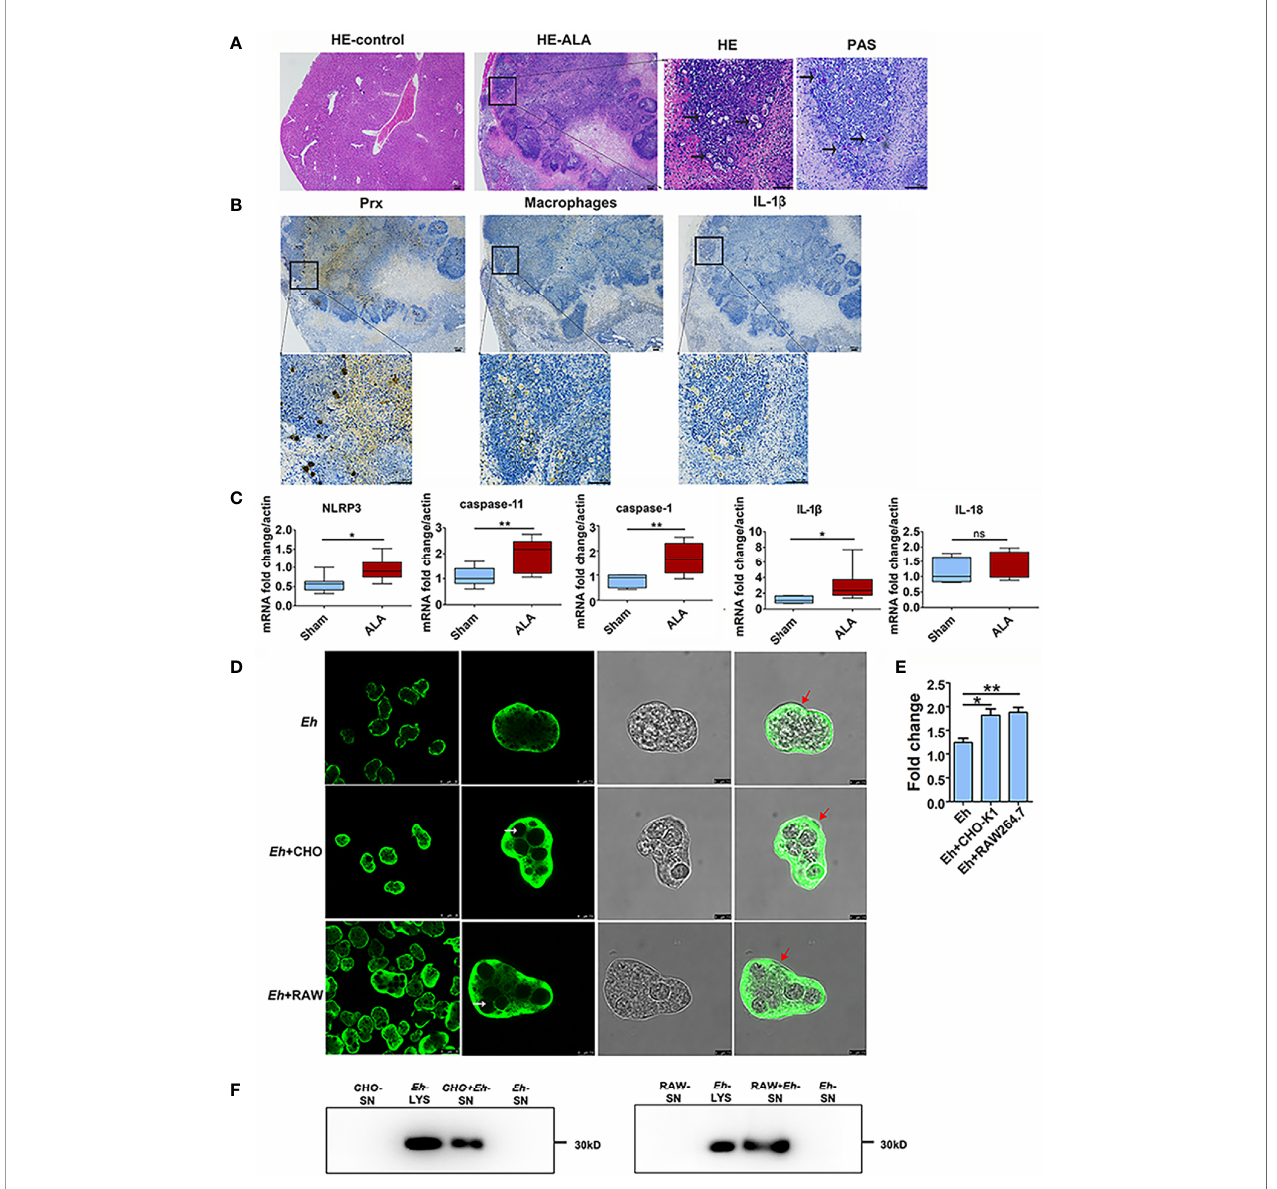
FIGURE 1 | Priming of NLRP3 in fl ammasome in ALA tissue and Secretion of Prx in E histolytica . (A) Construction of mice ALA model. Male C57BL/6 mice were inoculated with 1 × 10 6 trophozoites of the E histolytica SAW755CR strain/mouse. Five days after treatment, the ALA tissue was obtained. Sections from normal or ALA tissue were observed by HE and PAS staining. Bars: 100 m m. Black arrows: trophozoites. Experiments were repeated twice. (B) Immunohistochemical staining analysis of ALA. Sections of ALA tissue were incubated with anti-F4/80 antibody, mAb 4G6, or anti-IL-1 b antibody to detect distribution of macrophages, Prx of E histolytica , or IL-1 b in ALA tissue, respectively. Brown areas were considered positive. Bars: 100 m m. (C) Expression of NLRP3 in fl ammasome-related genes in ALA tissue. Male C57BL/6 mice were inoculated with 10 6 trophozoites of the E histolytica SAW755CR strain. Five days after infection, the expression levels of related genes in ALA tissue were measured through qPCR, and shown as 2- DD Ct of the target gene relative to b -actin, normalized with corresponding values in normal mice. In sham group, n = 6; in ALA group, n = 8. Experiments were repeated twice. (D) The location of Prx in trophozoites co-incubated with CHO-K1 or RAW264.7 cells. Trophozoites during the logarithmic growth phase were harvested and co-incubated with CHO-K1 or RAW264.7 cells. An hour after incubation, an E histolytica 4G6 monoclonal antibody (mAb) was used to measure the expression level and localization of Prx through immuno fl uorescence assay and laser confocal microscopy. White arrows: engulfed cells; red arrows: trophozoites membrane. Bars, 25 m m (the left column) or 7.5 m m (right three columns). (E) Quantitative analysis of Prx fl uorescence intensity of E histolytica . Cells were observed with the same laser intensity by laser confocal microscopy. The fl uorescence intensity of Prx was analyzed using ImageJ 1.52a. In all groups, n = 4. Experiments were repeated three times. (F) Prx secretion from E histolytica trophozoites was detected by western blotting. After incubated with CHO-K1 or RAW264.7 cells in serum-free cell medium under anaerobic condition, cell supernatant was collected. Cold acetone precipitation was conducted to extract protein from culture supernatant. Afterwards, protein from the same volume of supernatant was analyzed by western blotting. Experiments were repeated twice. CHO, CHO-K1 cells; RAW, RAW264.7 cells; SN, supernatant; Lys, lysate. Statistical analysis was conducted by Student ’ s t -test, and data are presented as mean ± standard error of mean (SEM). *p < 0.05, **p < 0.01, ns, not signi fi